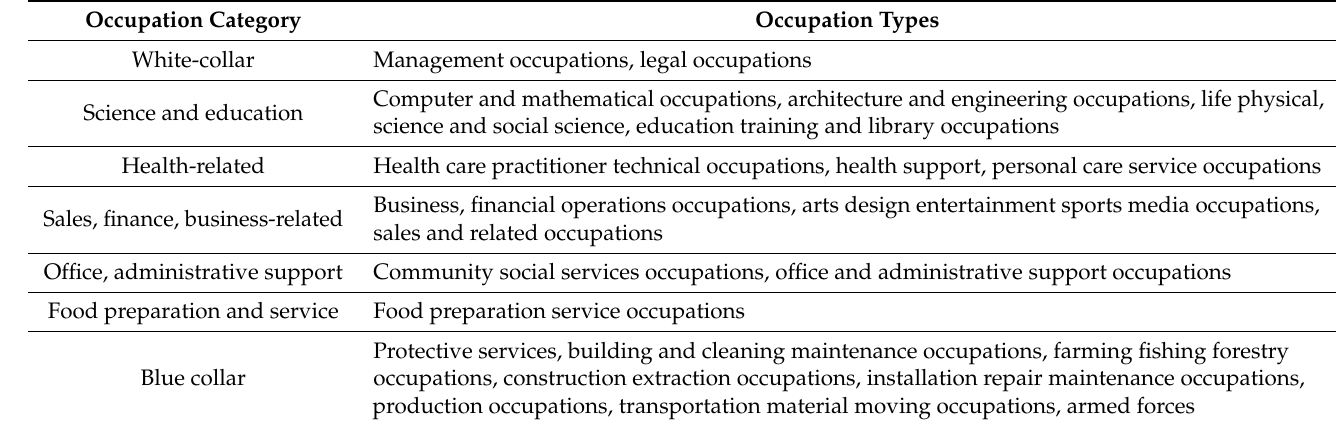
Table 1. Longest occupation categories based on similar job types held by the participants. These definitions of categories and the examples were modified and grouped together from the NHANES database [11], as presented by Wei et al. [13] (the following table is presented with the authors’